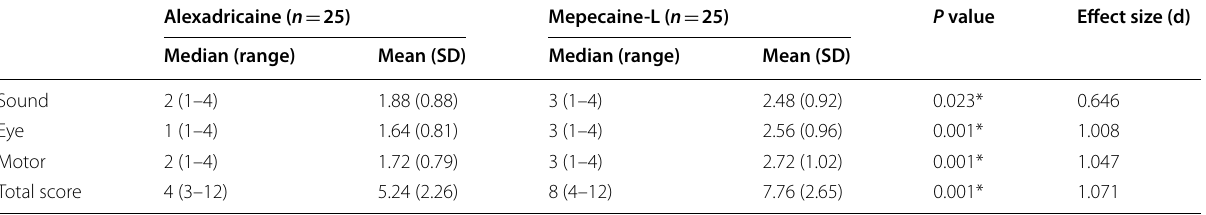
Table 5 Descriptive statistics and results of Mann–Whitney U test for comparison between pain scores in the two groups using sound, eye, and motor pain rating